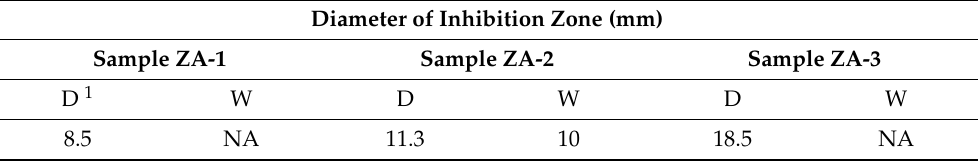
Table 2. Antimicrobial activity of prepared materials ZA-1, ZA-2, and ZA-3 against E. coli . Diameter of Inhibition Zone